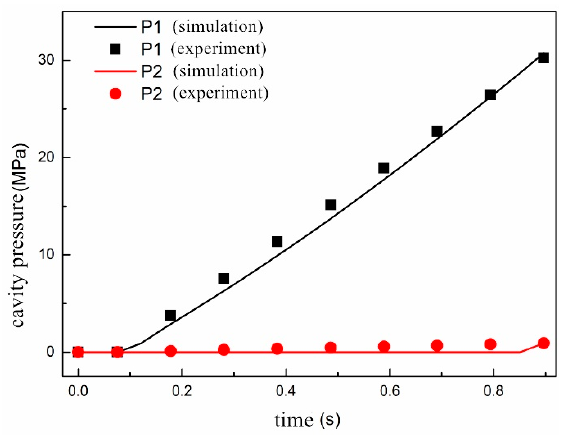
Figure 7. Comparison of cavity pressure variation at P1 and P2 over time.